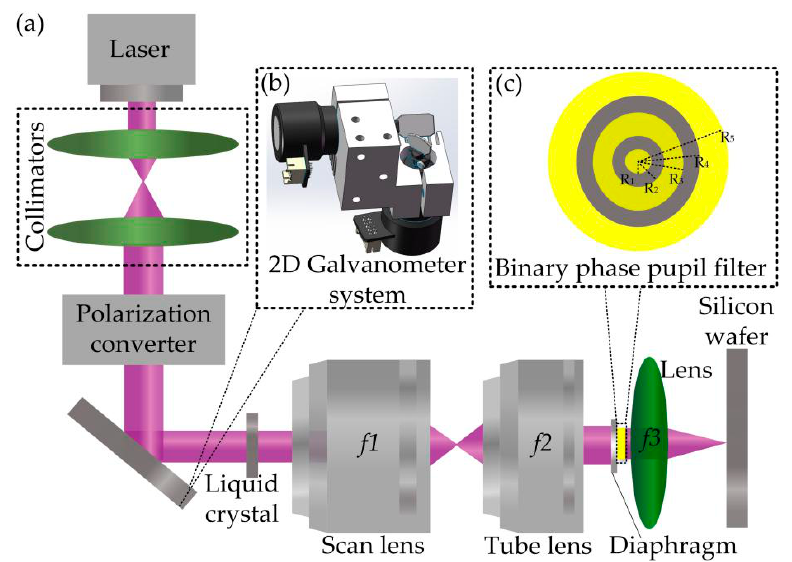
Figure 1. ( a ) Schematic of the optical setup. The insets ( b ) and ( c ) are enlarged views of the 2D galvanometer system and the binary phase pupil filter, respectively.